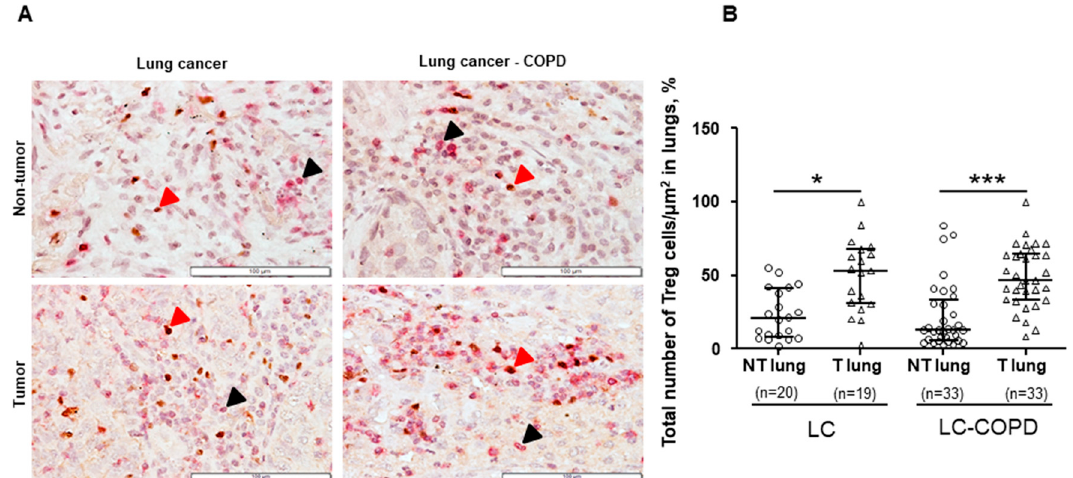
Figure 1. ( A ) Representative examples of double immunohistochemical staining for Treg cells (CD3-FOXP3 positively stained T cells) in LC and LC–COPD patients, respectively. All types of T cells (CD3 + ) are stained in only in red (black arrow), while Treg cells (CD3 + -FOXP3 + ) are specifically stained with both brown and red. ( B ) Median and interquartile ranges between 75 th and 25 th percentiles of proportions of Treg cells in the total measured area. Comparisons were made between the non-tumor (NT) and tumor (T) samples and the LC and LC–COPD groups. For technical reasons, the number of patients in each group or type of samples (tumor and non-tumor) may differ. Statistical significance: *, p ≤ 0.5; ***, p ≤ 0.001 between tumor and non-tumor lungs in either LC or LC–COPD patients. Definition of abbreviations: LC, lung cancer; COPD, chronic obstructive pulmonary disease; Treg, regulatory T cells; CD, cluster of differentiation; FOXP3, forkhead box P3.